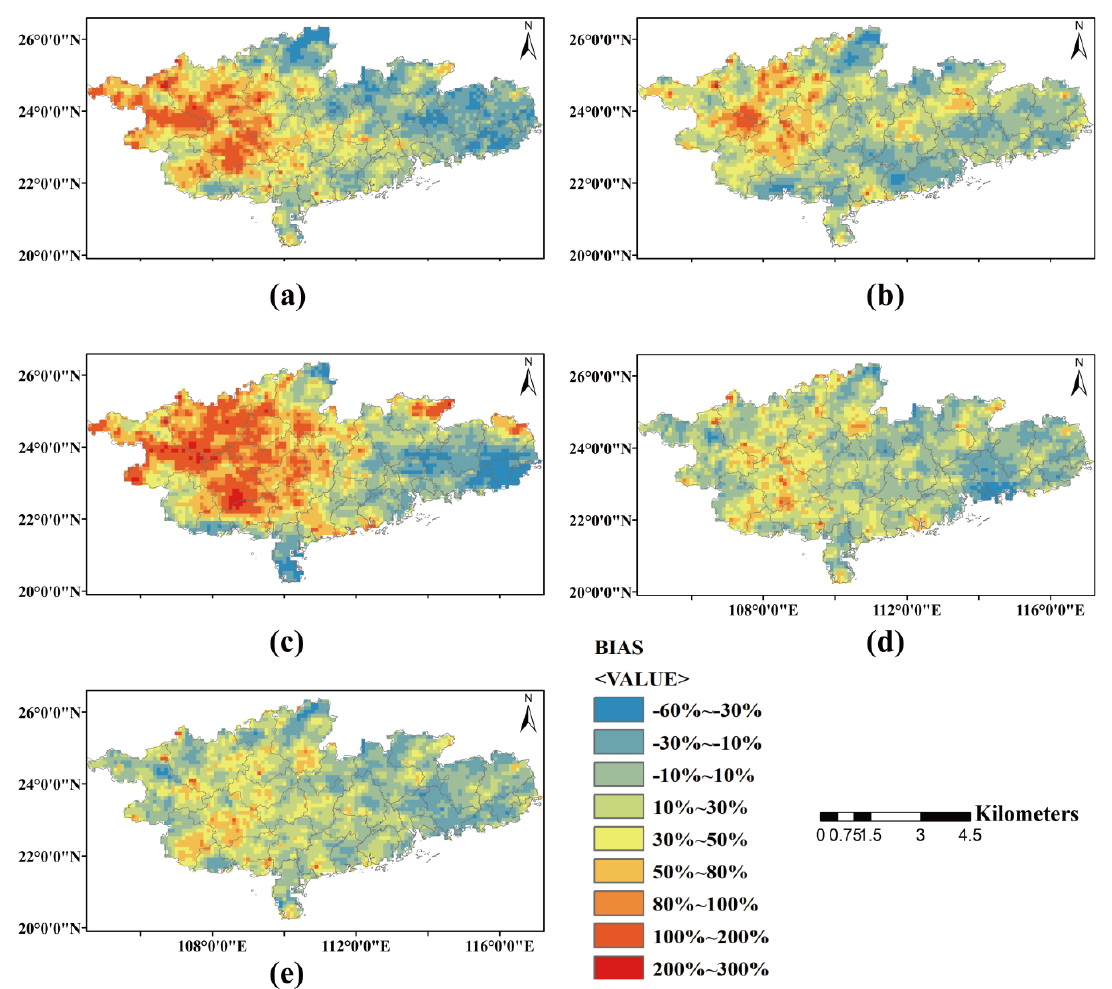
Figure 7. Spatial patterns in terms of relative bias (BIAS) based on ( a ) PERSIANN-CCS, ( b ) ERA5-Land, ( c ) FY-4A, ( d ) GSMaP, and ( e ) IMERG against CMPA at hourly scale over southern China in summer 2019.